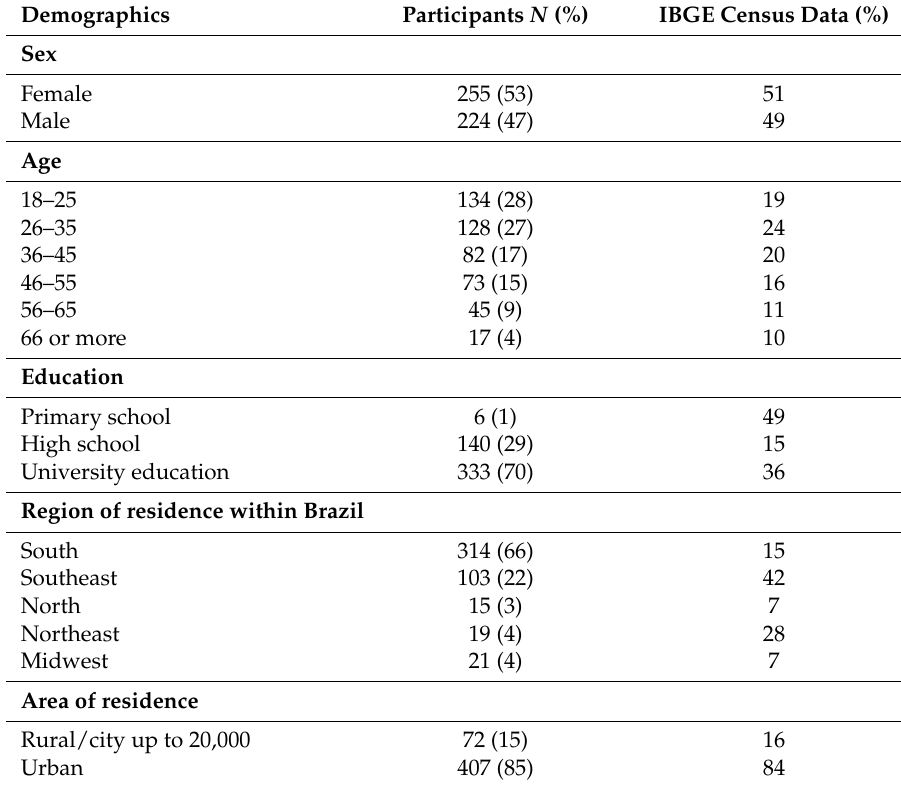
Table 1. Demographics of survey participants and of Brazilians according to latest Brazilian Institute of Geography and Statistics (IBGE) census